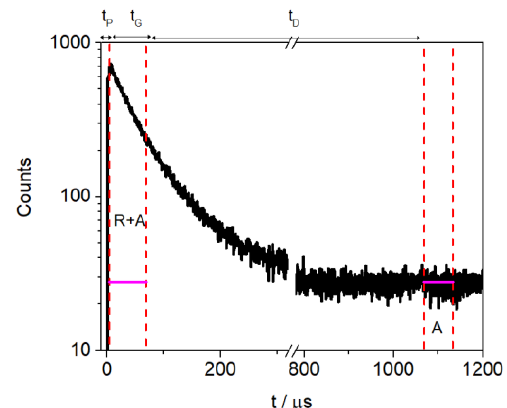
Figure 1: Rossi-alpha distribution from the measurement of a 252 Cf source.